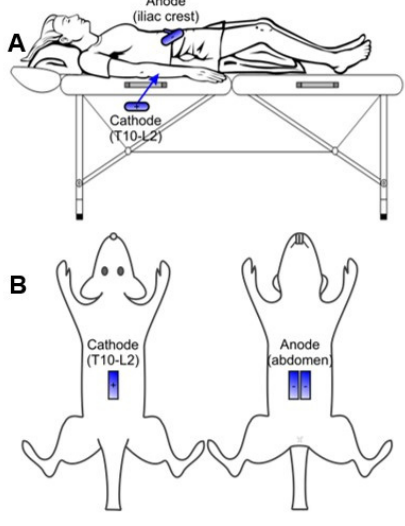
Figure 1. Transcutaneous electrode configuration. The cathode is placed over the T10-L2 vertebrae and the anodes over the iliac crests or abdomen in human ( A ) and rats ( B ).